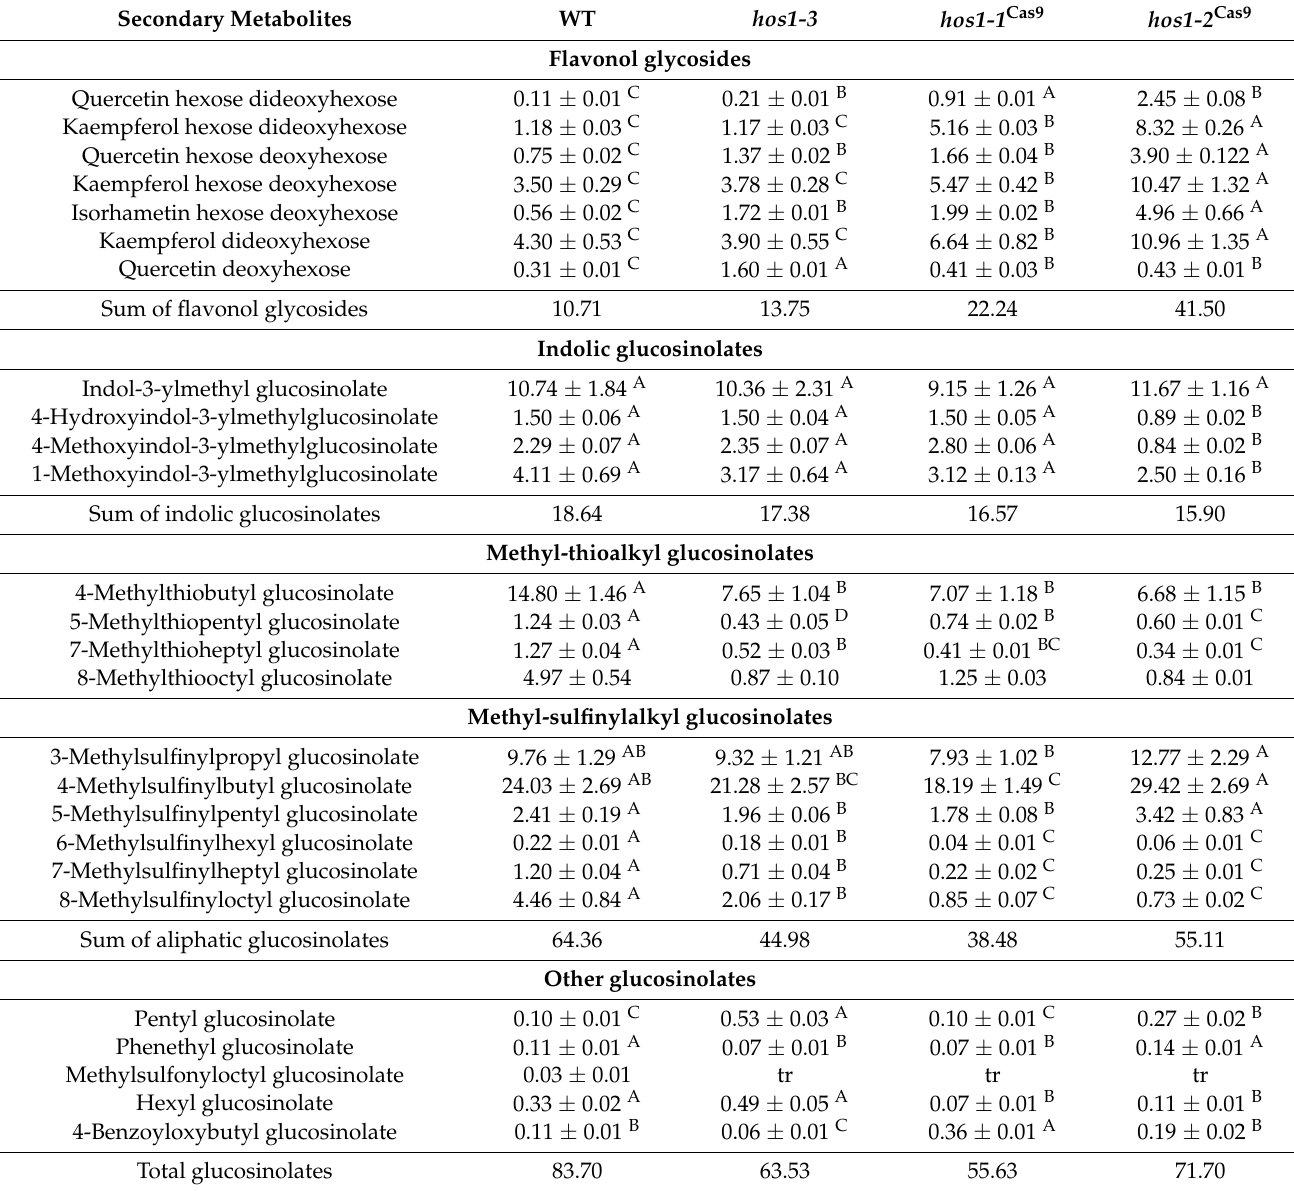
Table 2. Accumulation of secondary metabolites ( µ mol/g of dry weight) in control and hos1 mutants A. thaliana plantlets 1 . Secondary